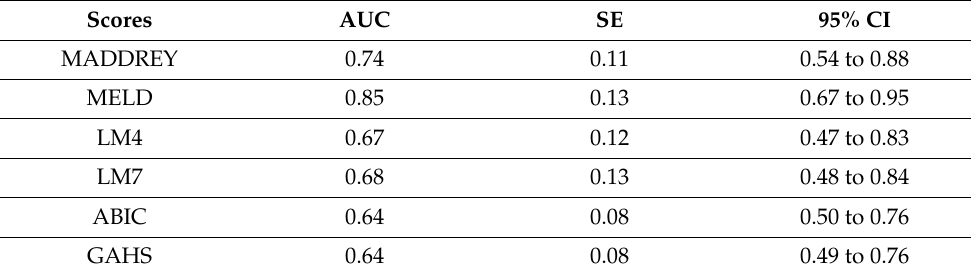
Table 3. Performance of different scores in predicting mortality at 28